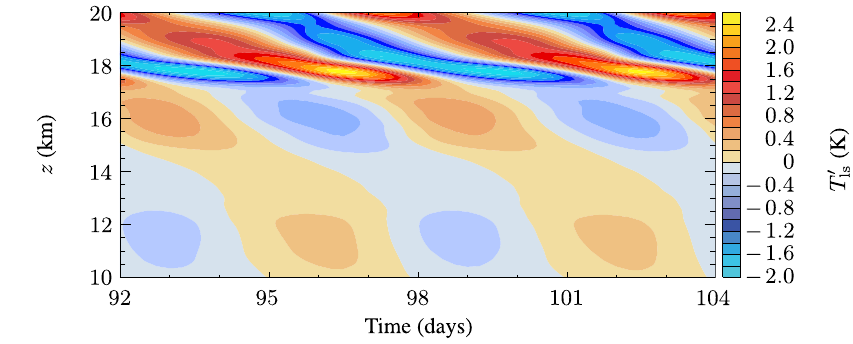
Fig. 2. Wave temperature perturbations at x = 3000km (middle of the domain) as a function of time and altitude.